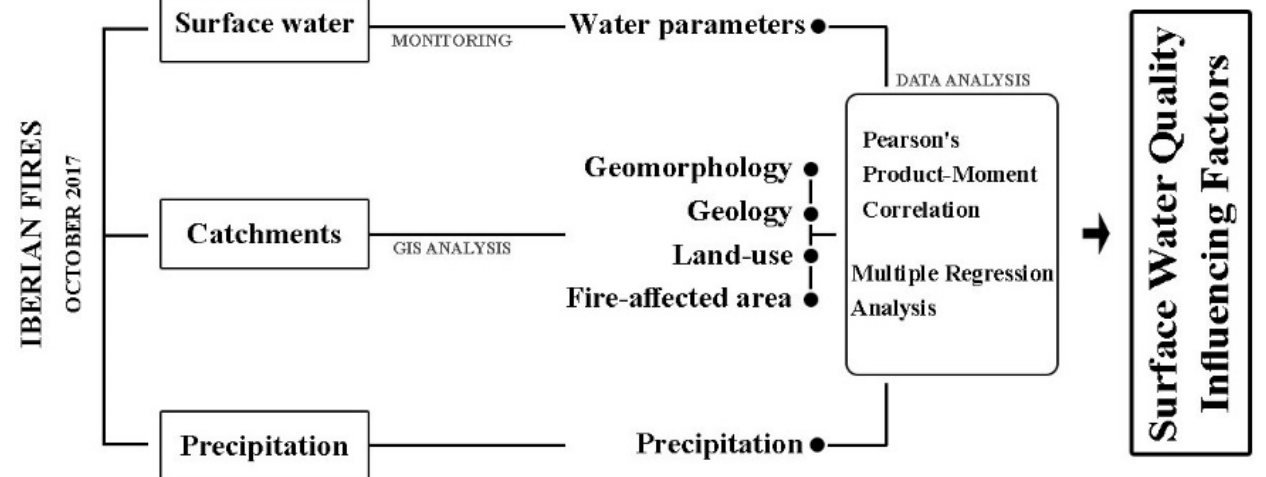
Figure 1. Conceptual model for determination of influences on water quality.